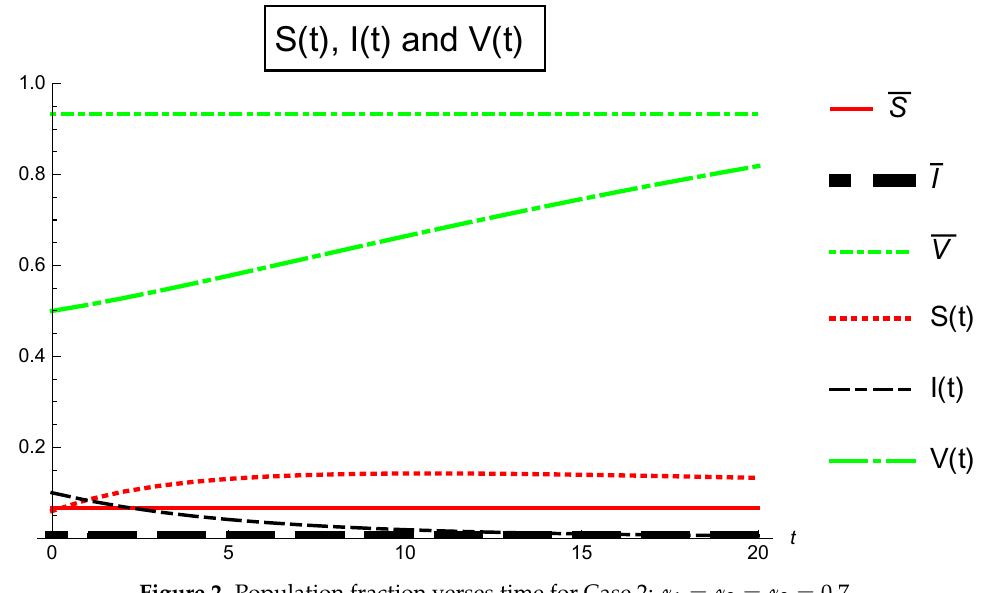
Figure 2. Population fraction verses time for Case 2: α 1 = α 2 = α 3 = 0.7. Table 4. α 1 = α 2 = α 3 =